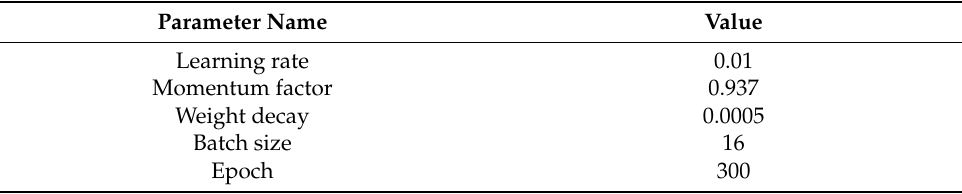
Table 2. Parameter